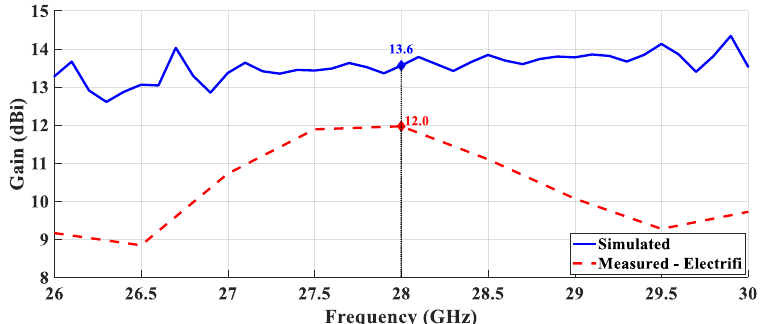
Figure 15. Comparison between simulated and measured gain over the frequency—horn antenna printed with the conductive filament.